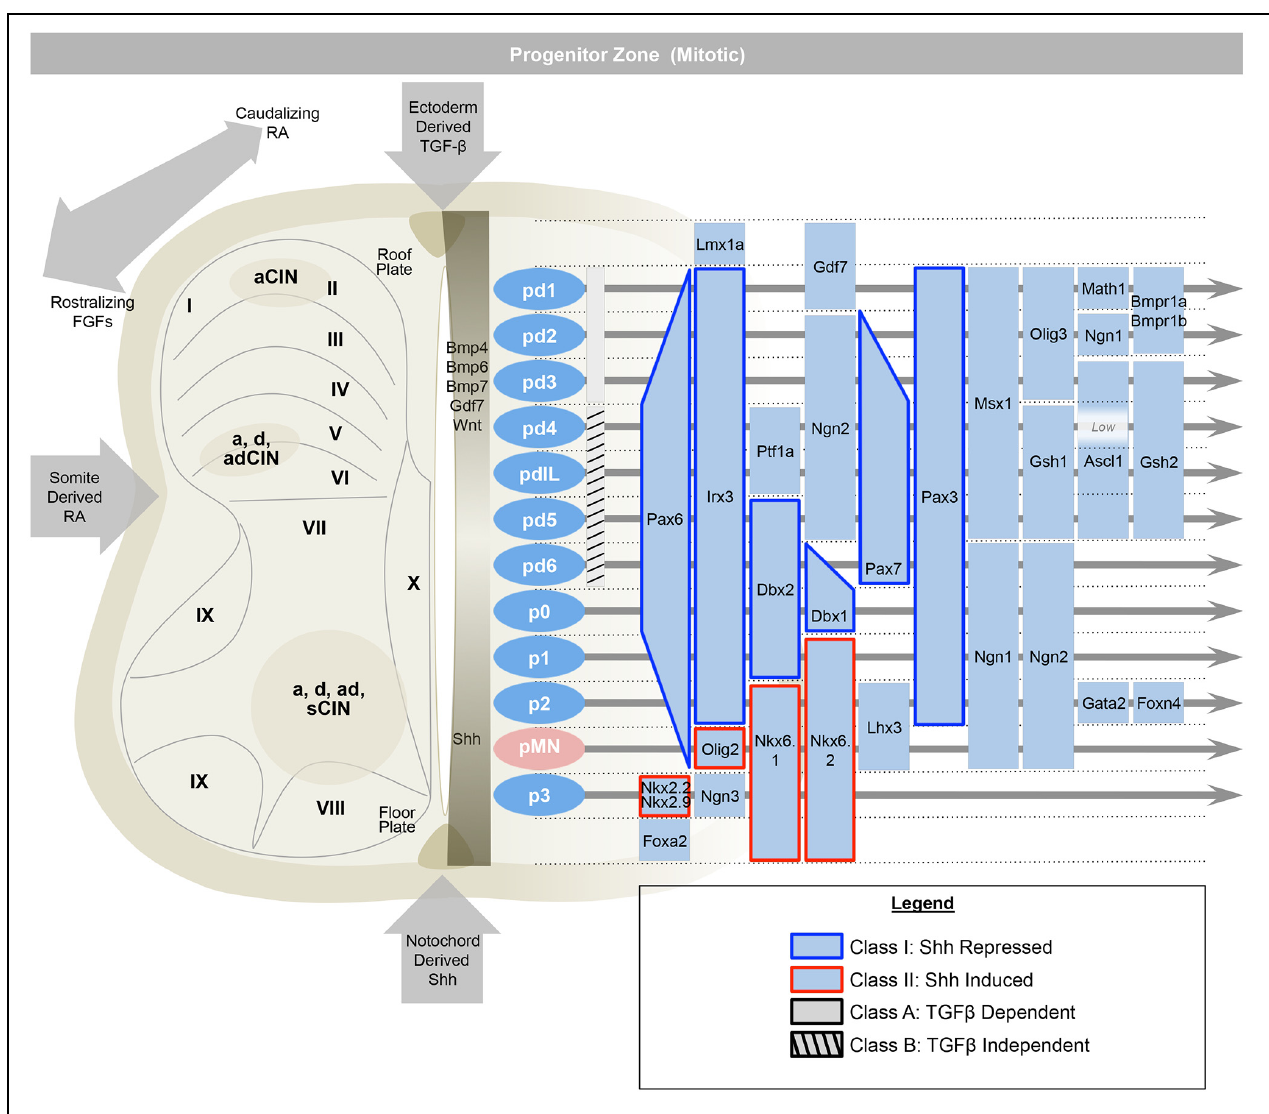
FIGURE 2 | The early spinal cord (e9.5–e11) is influenced by Sonic-hedgehog (Shh) ventrally, ectoderm-derived TGF-beta family members dorsally, and retinoic acid from the somite, laterally. This establishes 13 progenitor domains (including the late born pdILA and pdILB) that express transcription factors that help to define progenitor identities and